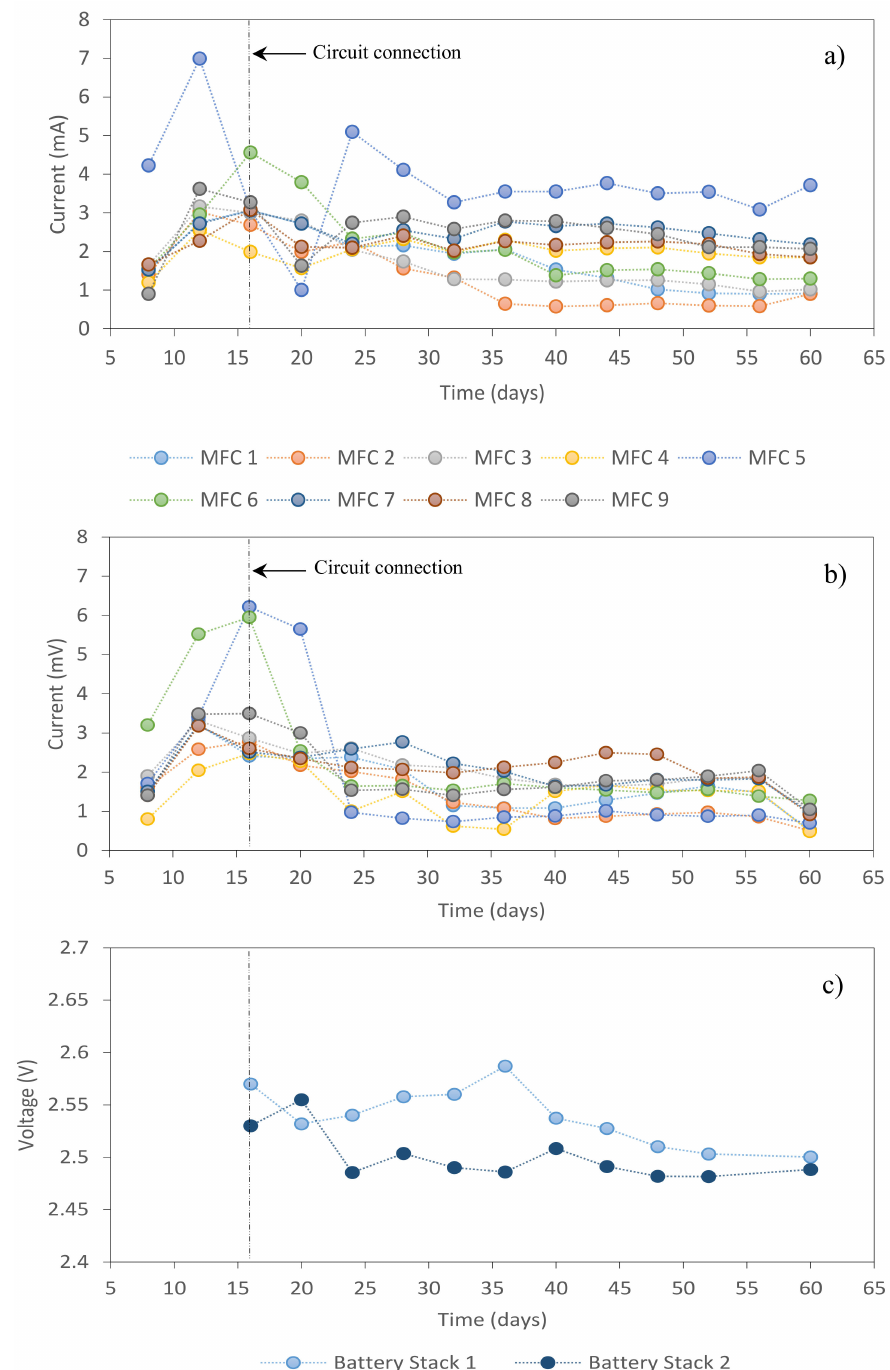
Figure 3. Current values of the cells in ( a ) Stack 1 and ( b ) Stack 2 over the 60-day period of the experiment ( c ) Voltage values of the energy-harvesting circuit battery circuit for Stack 1 and Stack 2 over